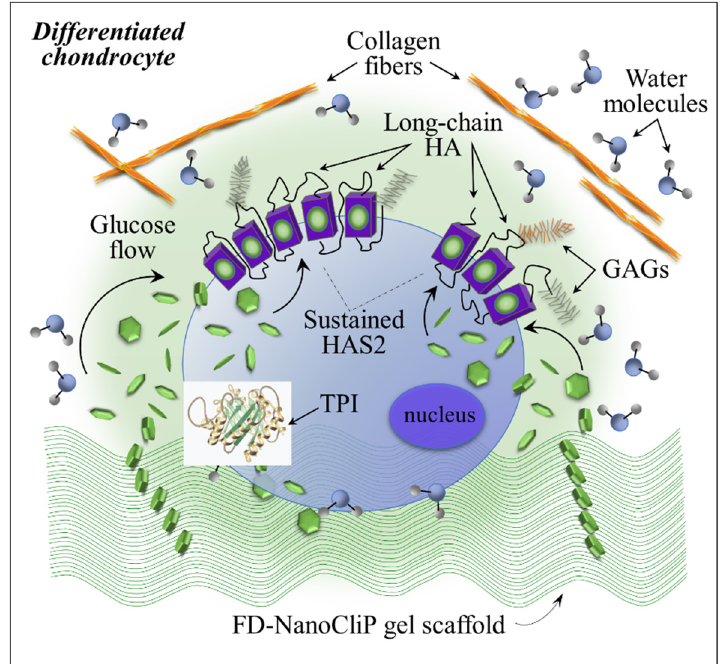
Figure 10. Schematic of metabolic effects of the pullulan molecules of the NanoCliP-FD gel scaffold on